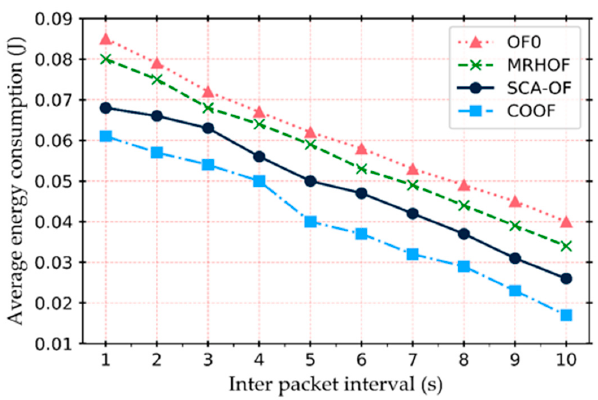
Figure 13. Average energy consumption with respect to different inter packet interval.